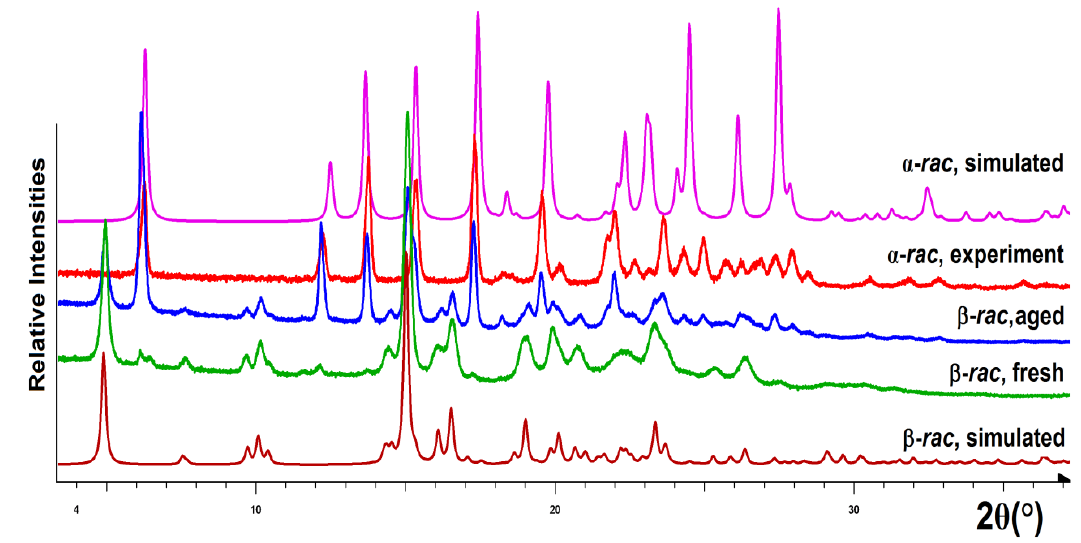
Figure7. ComparisonofexperimentalandsimulatedPXRDpatternsfor α - rac - 1 and β - rac - 1 polymorphs. Figure 7. Comparison of experimental and simulated PXRD patterns for α - rac - 1 and β - rac - 1 polymorphs.